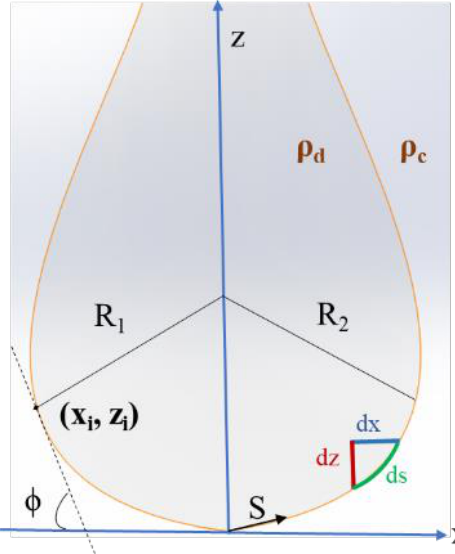
Figure 19. Schematic diagram of the characteristics of the pendant drop.